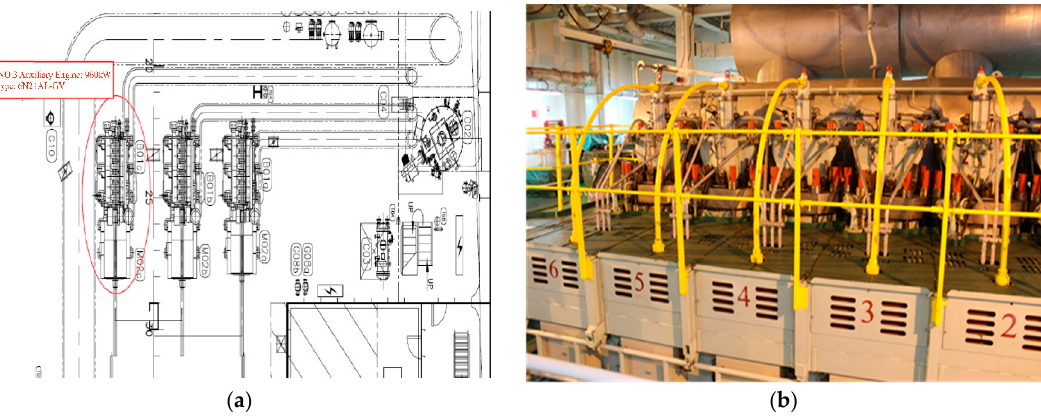
Figure 4. Diesel generators on the ‘COSCO Tengfei’. ( a ) Configuration of the three diesel generators; ( b ) Schematic of the 1020 kW diesel generator.